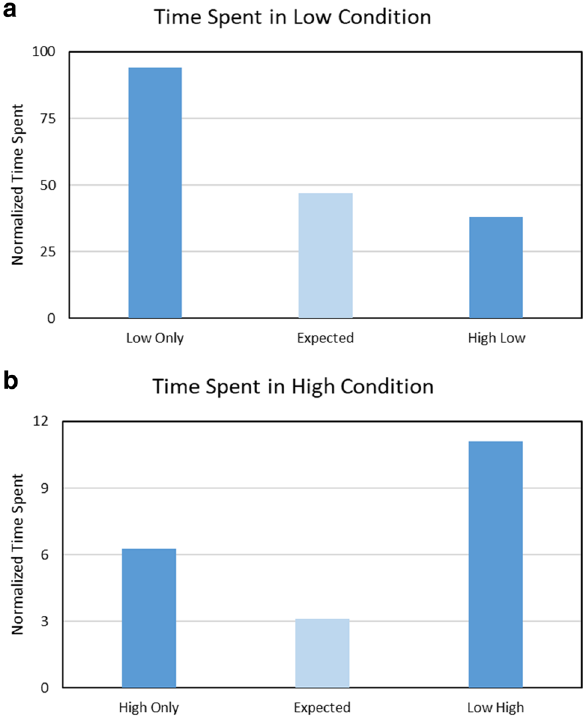
Fig. 8 Summary of time spent by each test variation in the ( a ) low deposition rate condition and ( b ) high deposition rate condition. All data is normalized against a sample with no CMAS deposition. Light blue bars indicate the expected life of the samples as pre- dicted by the linear damage model. Dark blue bars indicate actual life of different samples under the given condition. The axis in ( b ) is adjusted for better